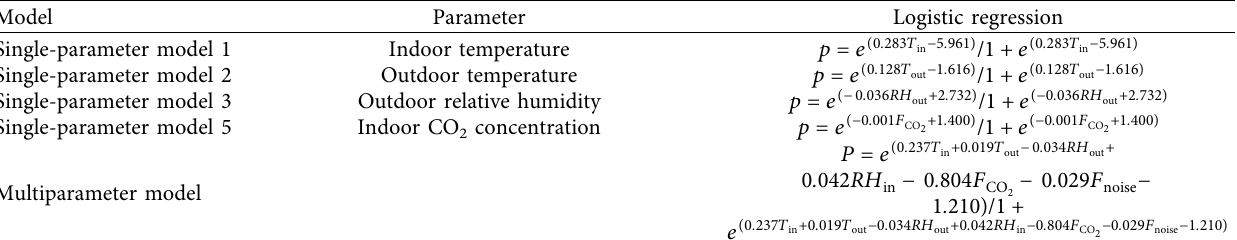
Table 7: Logistic regression equations with single and multiple parameters.